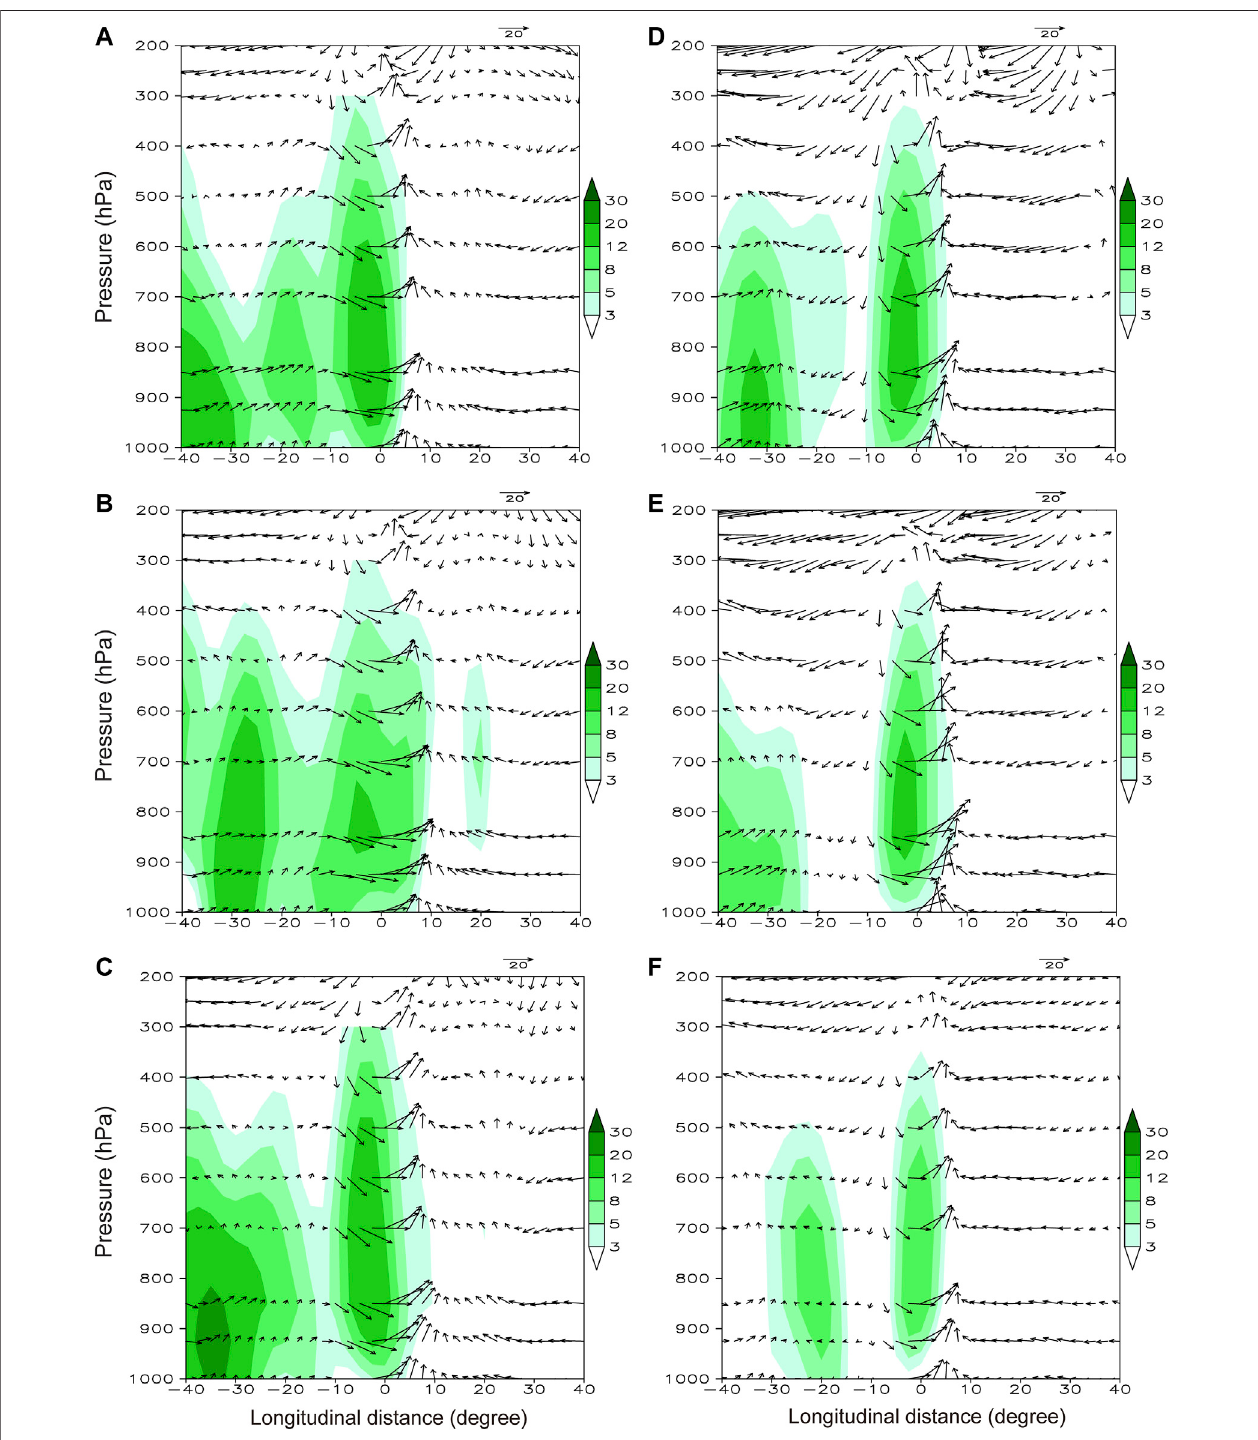
FIGURE 7 | Height – time evolution of the magnitude of water vapor fl ux (shaded; units: kg m − 1 s − 1 ) and horizontal wind (vectors; units: m s − 1 ) of the composited (A – C) ERLTC and (D – F) NERLTC 2 days before (A, D) , 1 day before (B, E) , and on the day (C, F) of the extreme or non-extreme rainfall.